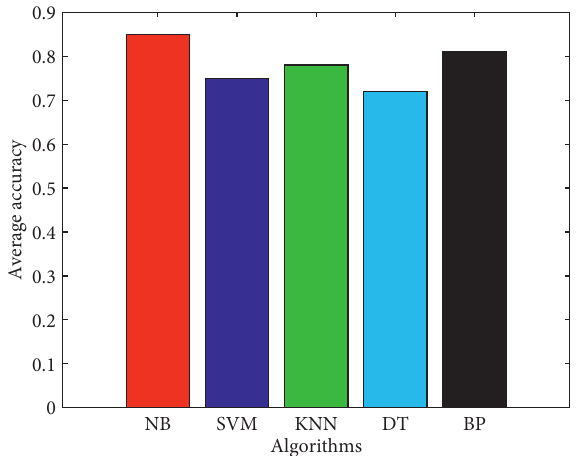
Figure 2: Comparison of classification accuracy of different